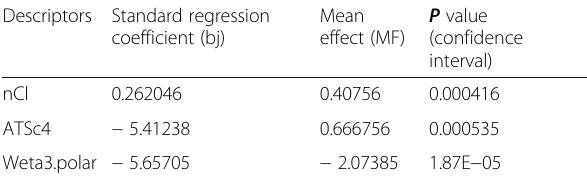
Table 8 Standard regression coefficients “ bj ” , the values of mean effect (ME) and confidence interval ( p values) Descriptors Standard regression coefficient (bj)